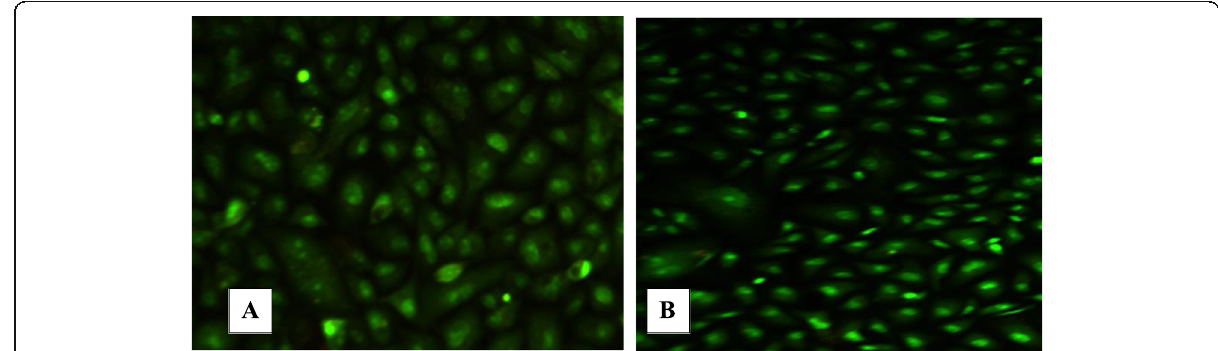
Fig. 3 Aciridine orange staining of Vero cell monolayers at control and NPs treated conditions. a Untreated cells. b Cells were treated with 100 μ g/ml of Ag